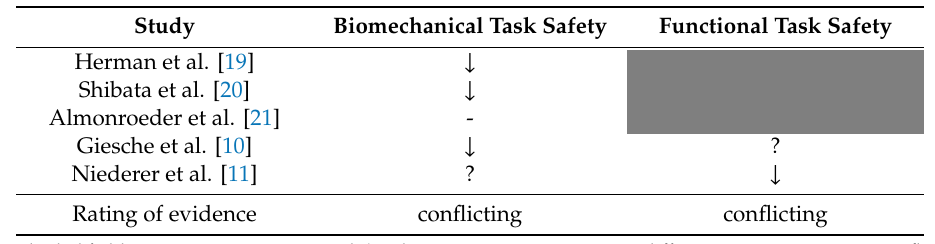
Gray-shaded fields: parameter not examined, ↓ = decrease in parameter, - = no di ff erence in parameter, ? = conflicting results. Columns show summarized outcomes grouped as biomechanical (e.g., joint moments / angles) and functional task safety (e.g., success in decision-making or valid trials in jump